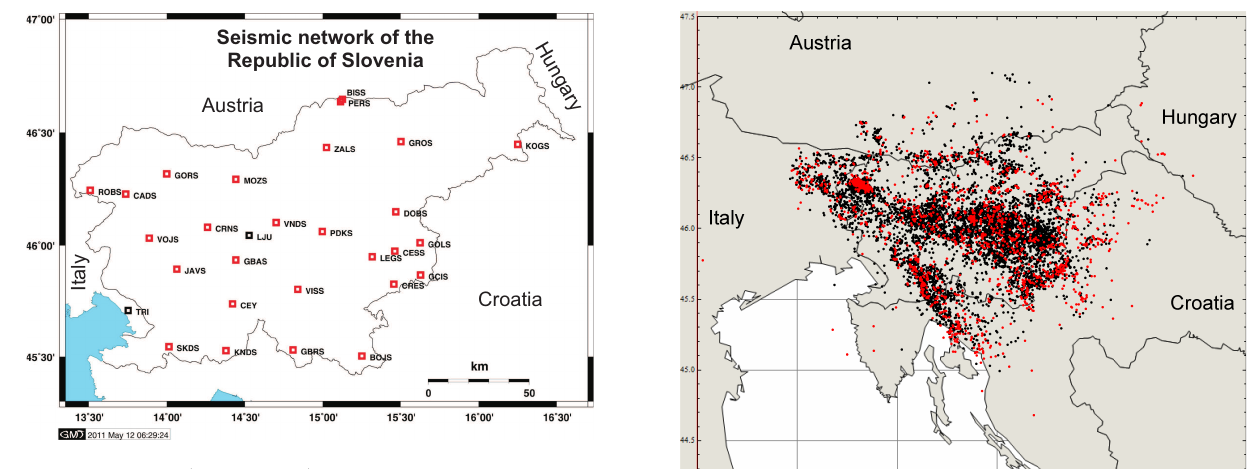
Fig. 1. The stations (open squares) of the Seismic network of the Republic of Slovenia that are used in the study. Black squares indicate seismic stations Trieste (TRI) and Ljubljana (LJU) that were used in the determination of the presently used M LV magnitude equation (Eq. 1). Fig. 2. Black dots denote earthquakes from the period 1997 to 2010 that are considered in the study. The earthquakes that are actually used in the calculation of the parameters in the M WA magnitude equation are coloured red.